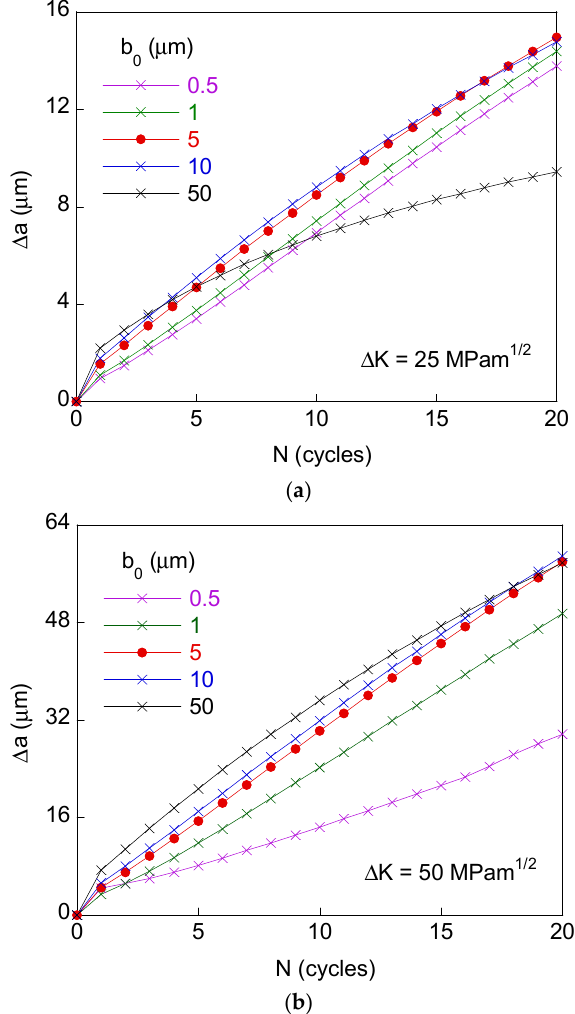
Figure 3. Crack growth vs. number of cycles: ( a ) Δ K = 25 MPam 1/2 and ( b ) Δ K = 50 MPam 1/2 .